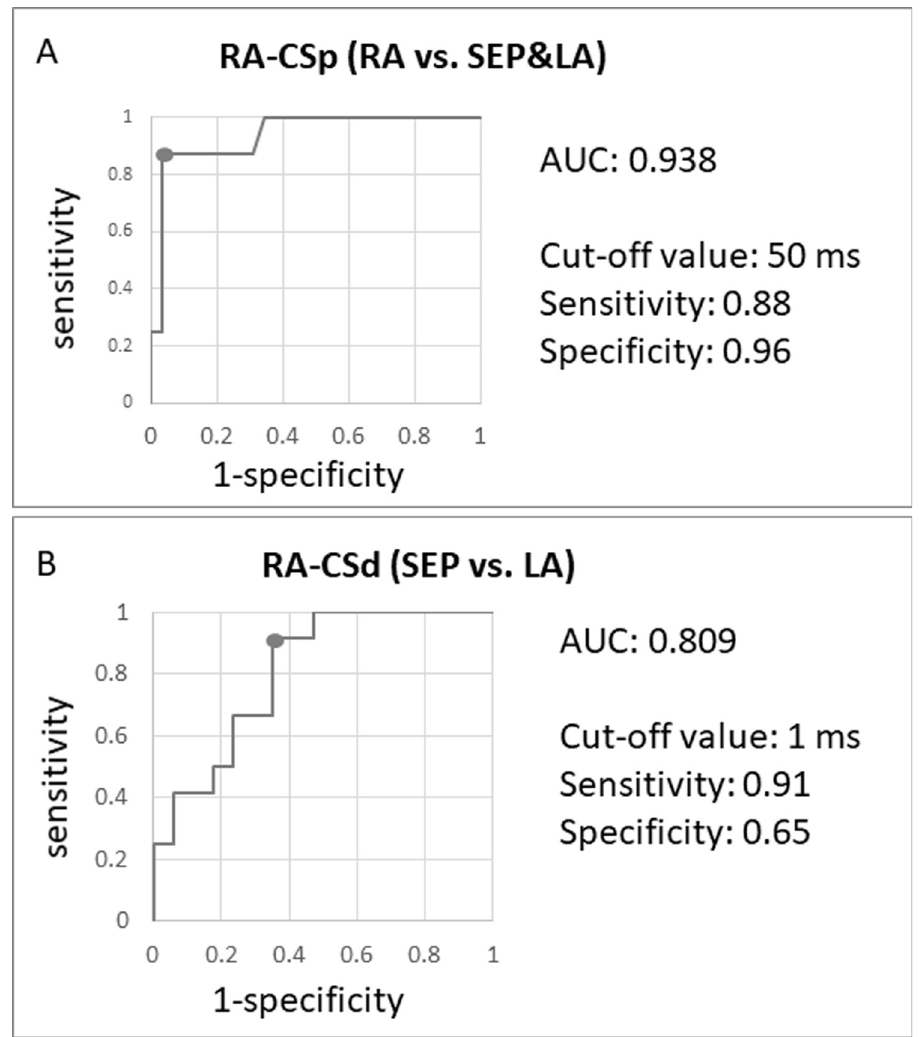
Fig 3. Receiver operating characteristic curves and cut-off value to distinguish the areas of non-PV trigger. A. To distinguish RA from SEP and LA with RA-CSp. B, To distinguish SEP from LA with RA-CSd. RA-CSp, intra-atrial activation interval from the earliest in RA to proximal CS; RA-CSd, intra-atrial activation interval from the earliest in RA to distal CS; RA, right atrium; CS, coronary sinus; SEP, atrial septum; LA, left atrium; AUC, area under the